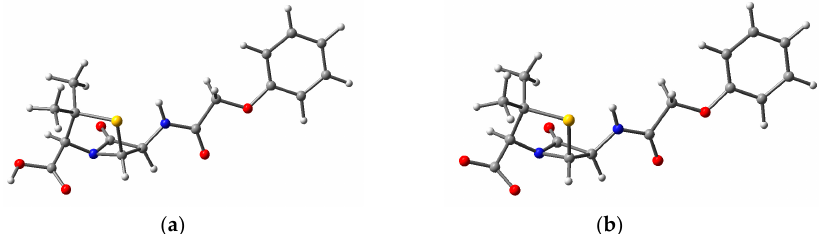
Figure 15. The optimized structure of ( a ) neutral and ( b ) deprotonated penicillin V calculated by DFT at the B3LYP/3-21G(d) level. Atom colors: C, grey; O, red; N, blue; S, yellow; and H, light grey.